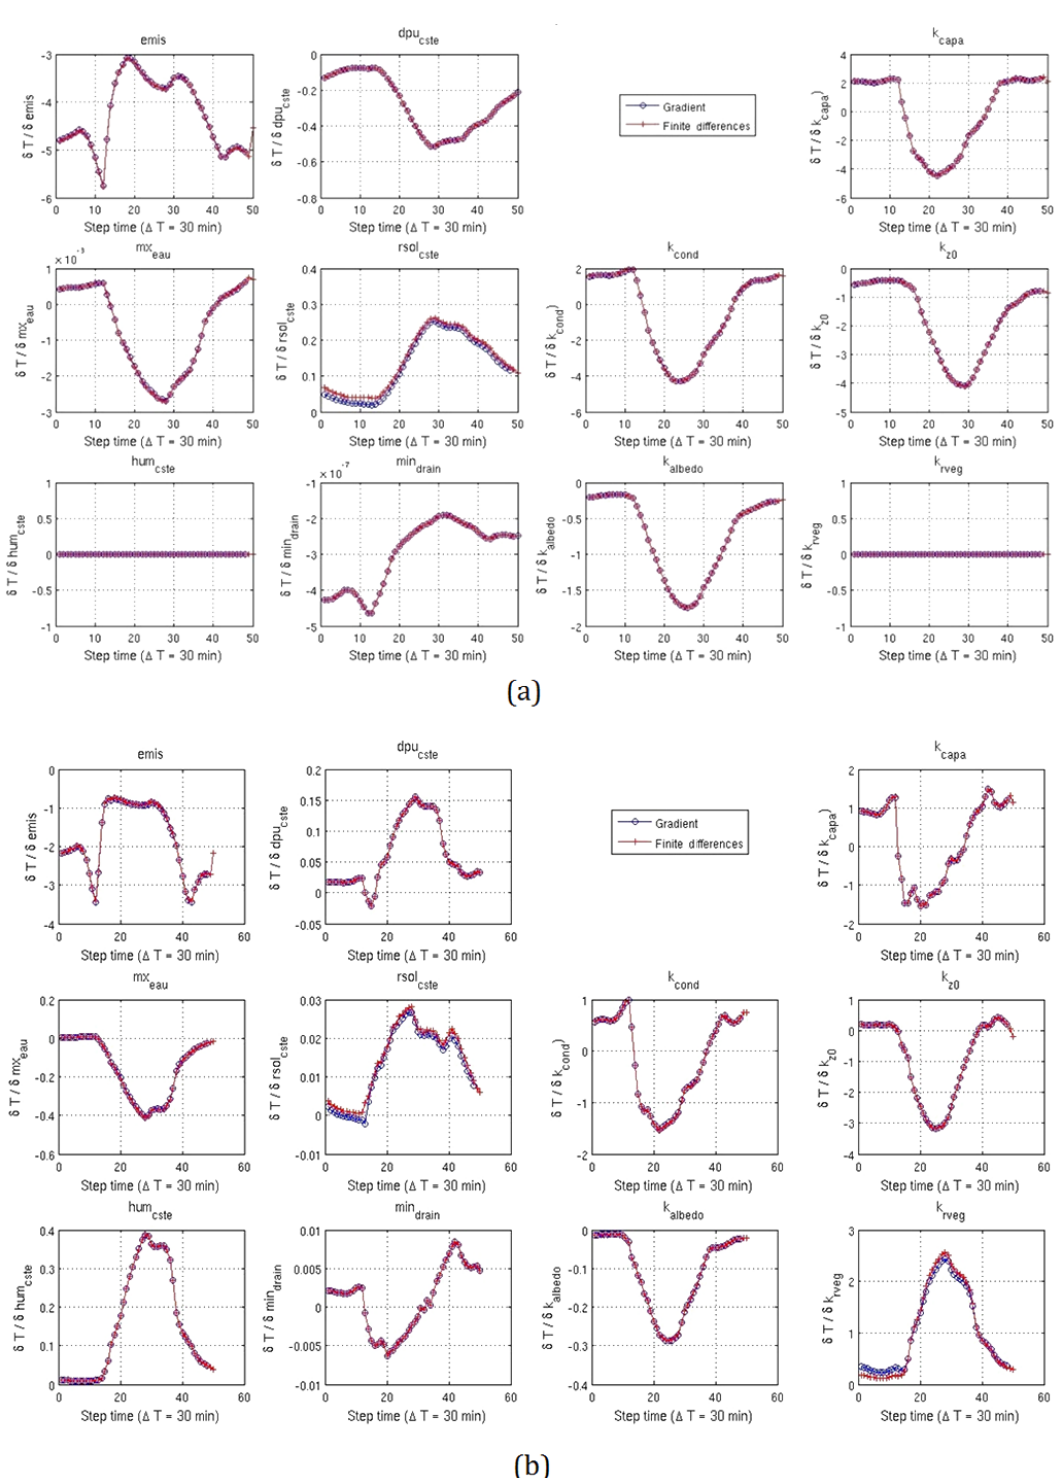
Figure 4. Comparisons for 28 August 1996 at Harvard Forest of the sensitivities obtained for each control parameter with both the finite differences and the model gradients computed with the adjoint model. Sensitivity analysis results for PFT 1 are in (a) and for PFT 12 in (b) . The sensitivities were computed on the surface temperature for Harvard Forest. Blue curves represent the LST derivative with respect to each parameter given by the adjoint each half hour over a day. Red curves represent the LST derivative computed with a finite difference discretization of the